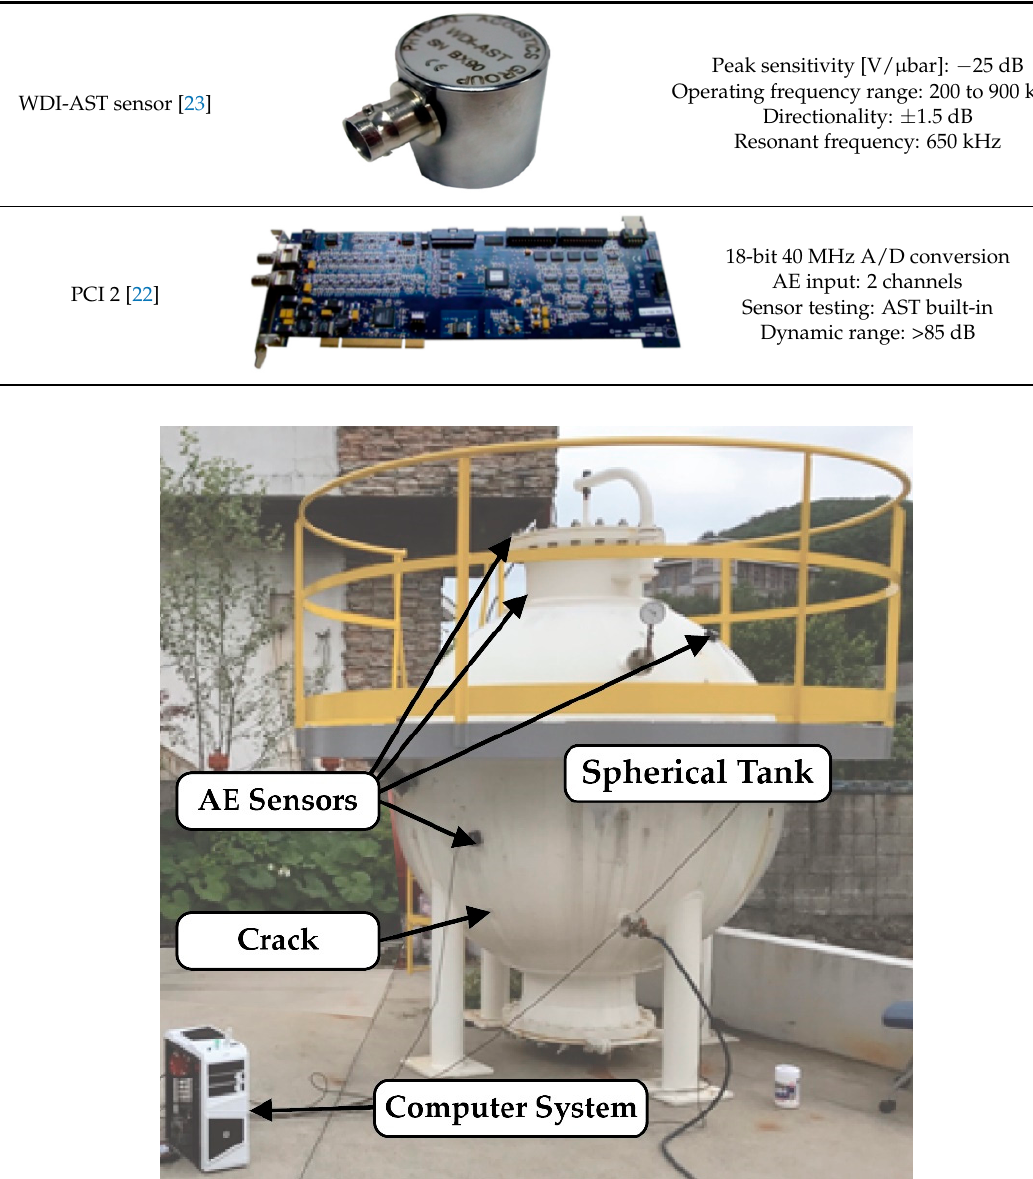
Figure 2. The testbed used to collect AE signals during the experiment.